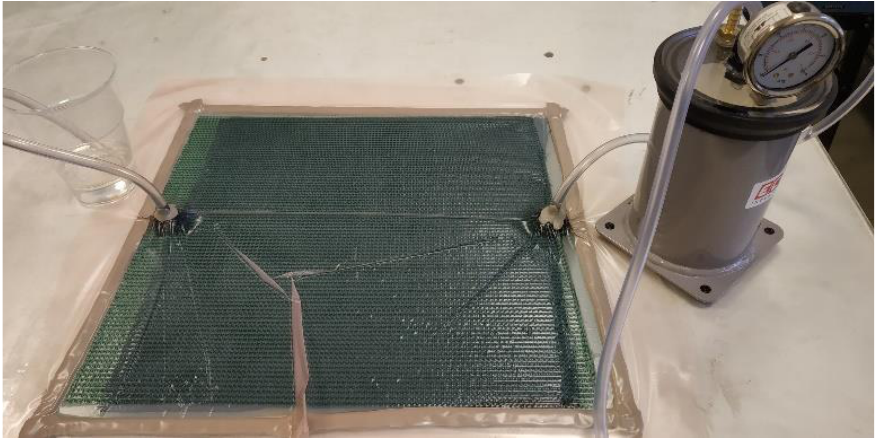
Figure 3. VARTM setup.